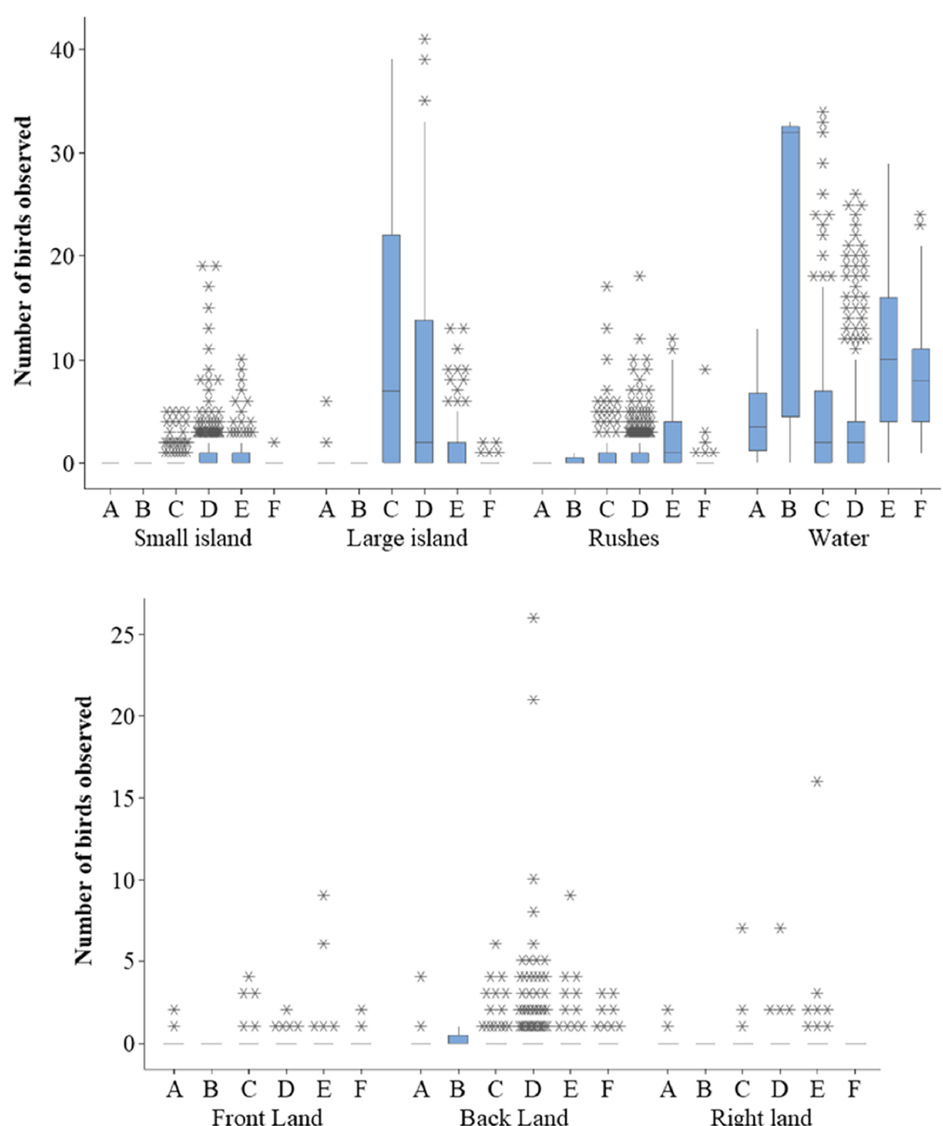
Figure 6. Count of birds in different outdoor enclosure zones by time of day. A = Early; B = Dawn; C = Morning; D = Afternoon; E = Dusk; F = Night. * show outliers. For outdoors SPI time of day showed a significant relationship with enclosure usage (F 5, 728.2 = 15.121; r 2 = 21%; p < 0.001) but month only showed a general trend (F 4, 56.7 = 2.453; r 2 = 21%; p = 0.056). For indoor SPI, there was a significant difference in indoor SPI for month (F 6, 89.2 = 3.234; r 2 = 17%; p = 0.006) and time of day (F 5, 862.1 = 3.149; r 2 = 17%; p = 0.008).